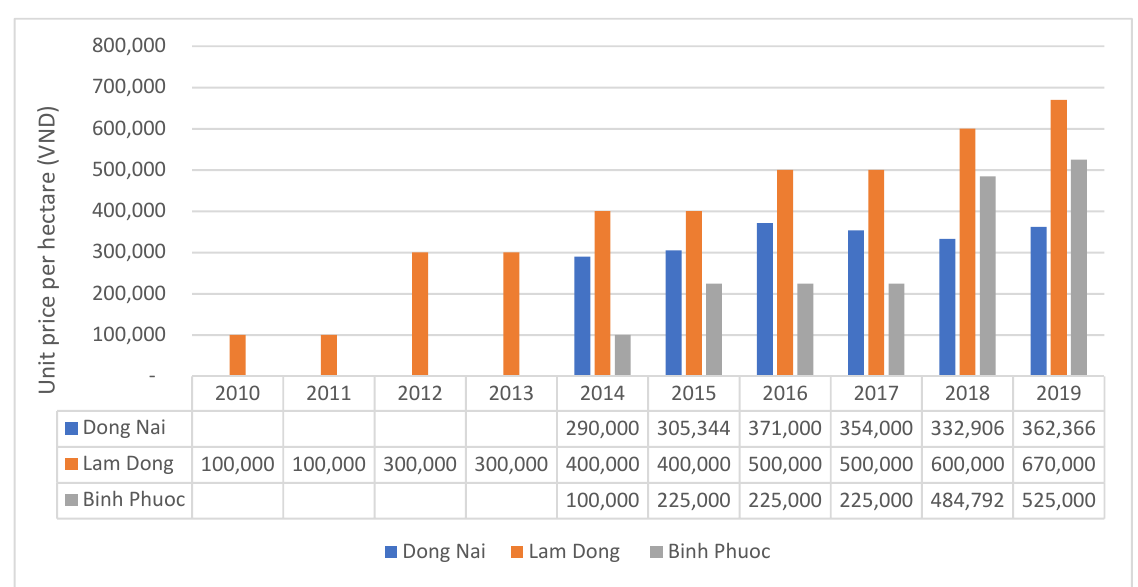
Figure 9. Unit prices for PFES and Decision 24 (only applies to Dong Nai). Source: Cat Tien National Park (2019).